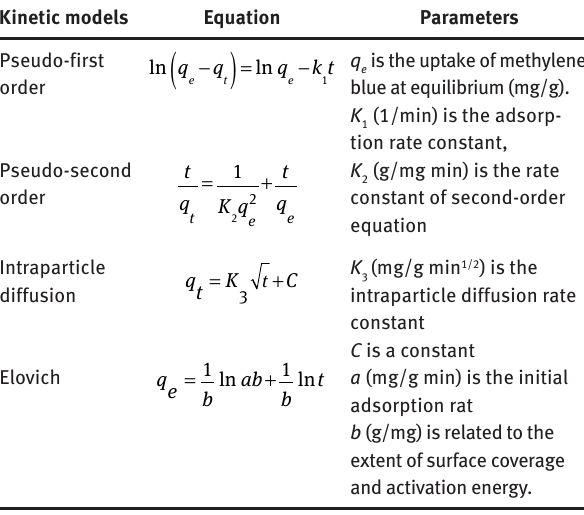
Table 5: Adsorption Kinetic models models adopted in this work and their parameters.